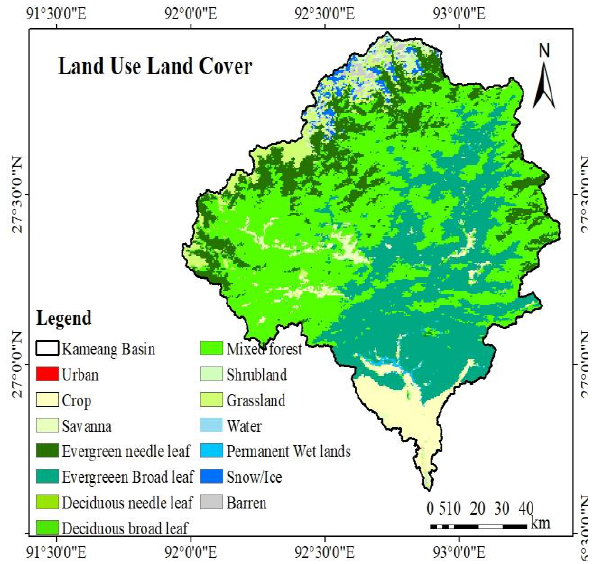
Figure 3 . Land Use Land Cover Map